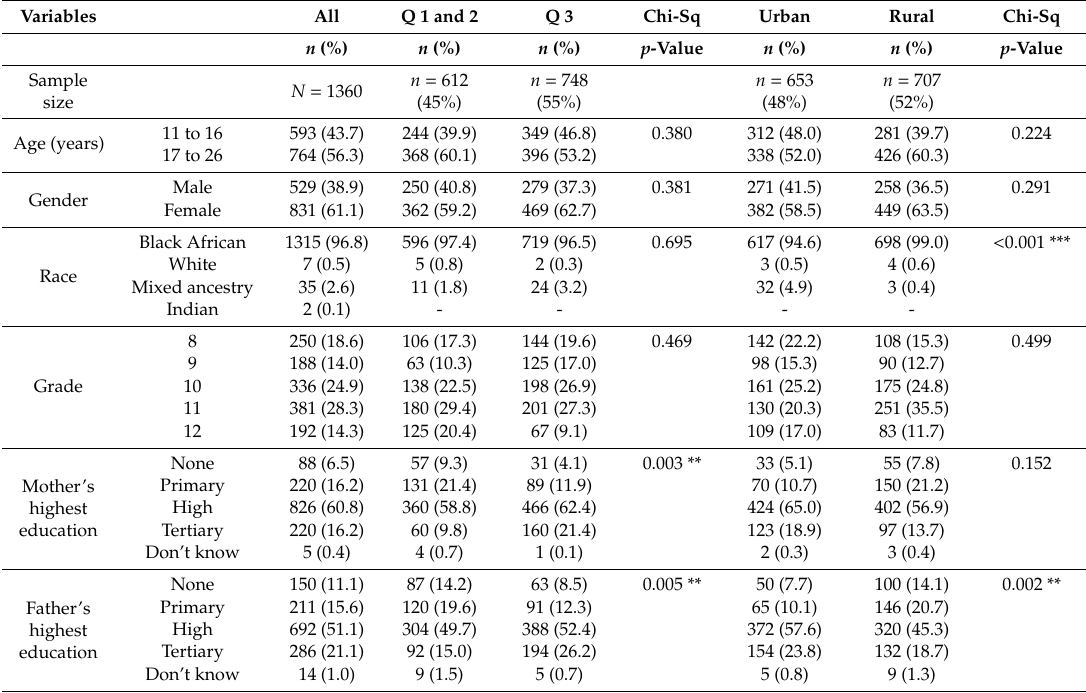
Table 1. Demographic characteristics of the learners by school quintiles and geographic areas.